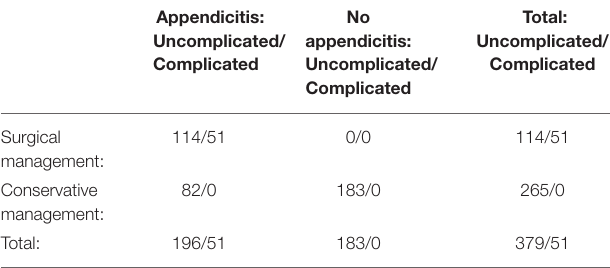
TABLE 1 | Counts of patients in different diagnosis, management, and severity